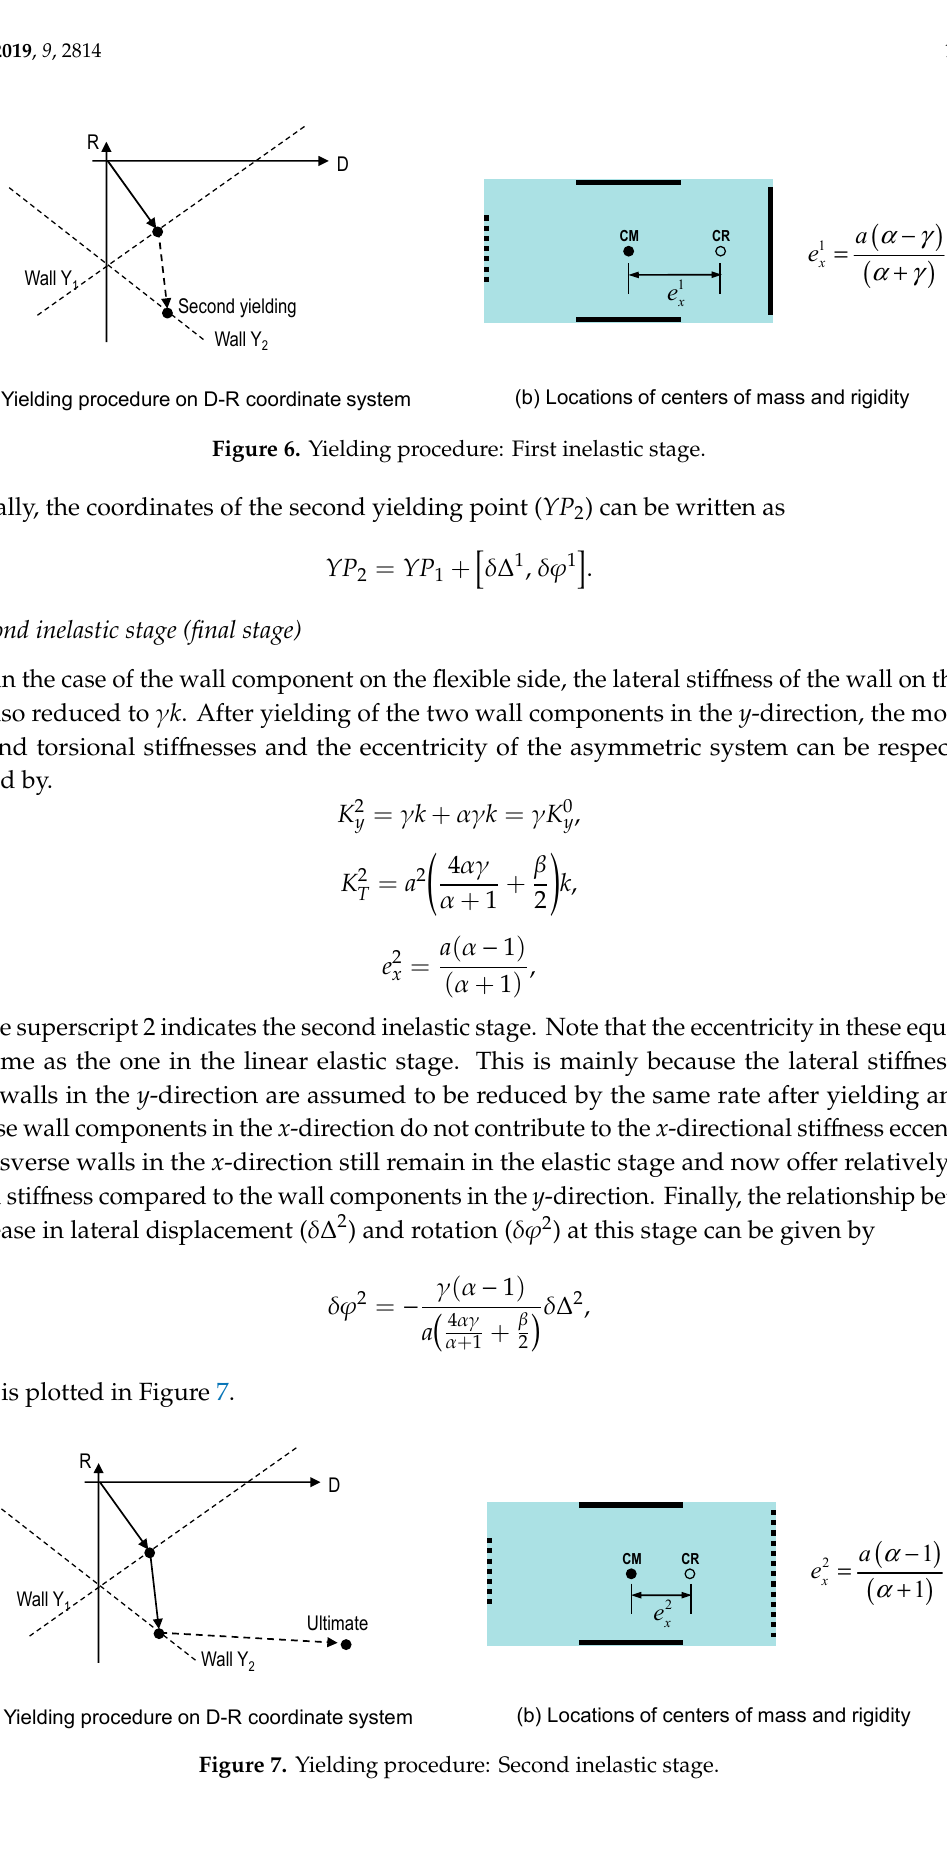
Figure 8. Comparison between inelastic torsional responses using the current design code and proposed approach. 3.3. Effect of Transverse Wall Stiffness on Yielding Procedure In the derivation introduced in Section 3.2, we assumed for simplicity that the two lateral force resisting walls have the same yield displacement. As a result, the wall on the flexible side always yields first, and then the wall on the stiff side. However, wall stiffness and yield displacement are determined mainly by the length of the wall. According to [24,25], the stiffness ( k ) and yield displacement ( u y ) of the lateral force resisting wall can be determined by the following two relationships: